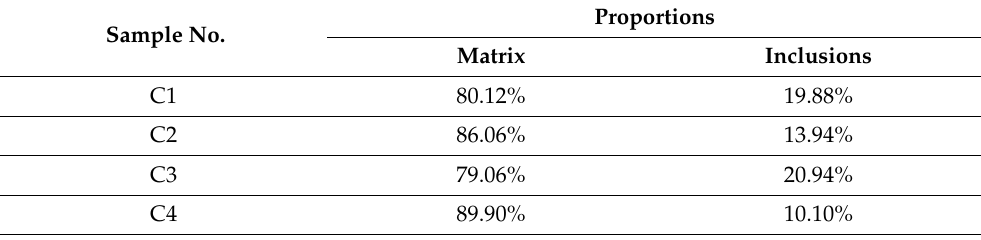
Figure 2. Complete scanning procedure and corresponding reconstructed 3D model of sample C1 (Internal structure shown in A-A cross-section; green: coal matrix, red: inclusions). Table 1. Composition of coal samples.